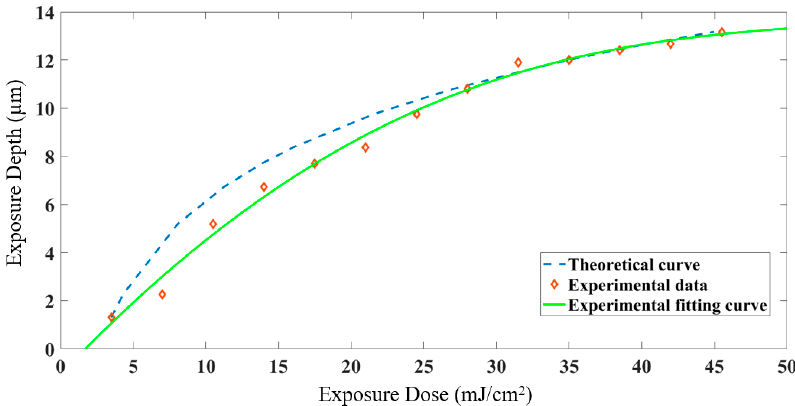
Figure 5. Nonlinear exposure curve.